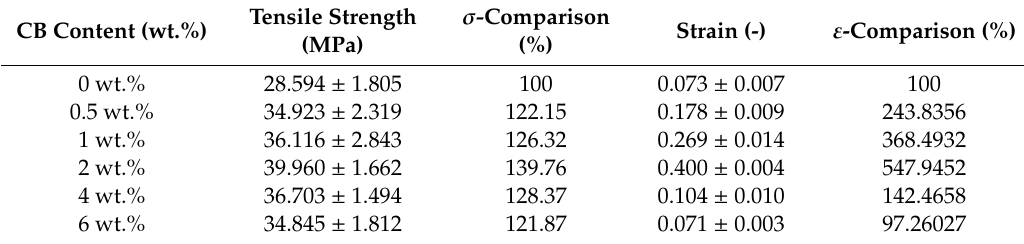
Tensile strength and strain of carbon black (CB)-modified polyvinylidene fluoride (PVDF) composites.